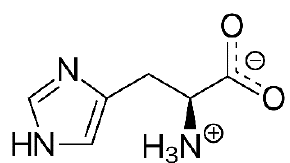
Figure 1. Histidine structure: histidine (HIS) contains an α -amino group, a carboxylic acid group, and an imidazole side chain. Under physiological conditions, the amino group is protonated and the carboxylic group is deprotonated. The imidazole ring is responsible for the proton buffering, metal ion chelating, and antioxidant properties.